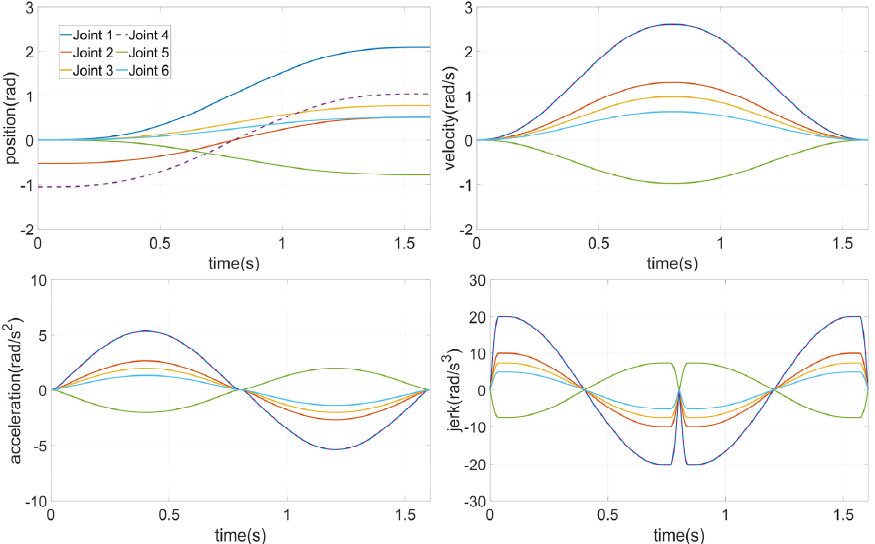
Figure 7. Joint position, velocity, acceleration and jerk profiles for the test task ( α = 0.5, β = 0.1).